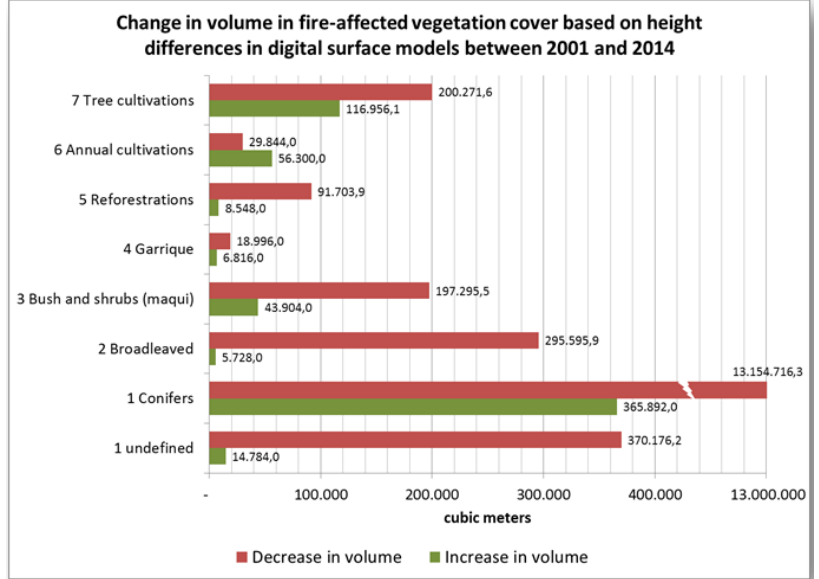
Figure 12. Change in volume in fire-affected vegetation